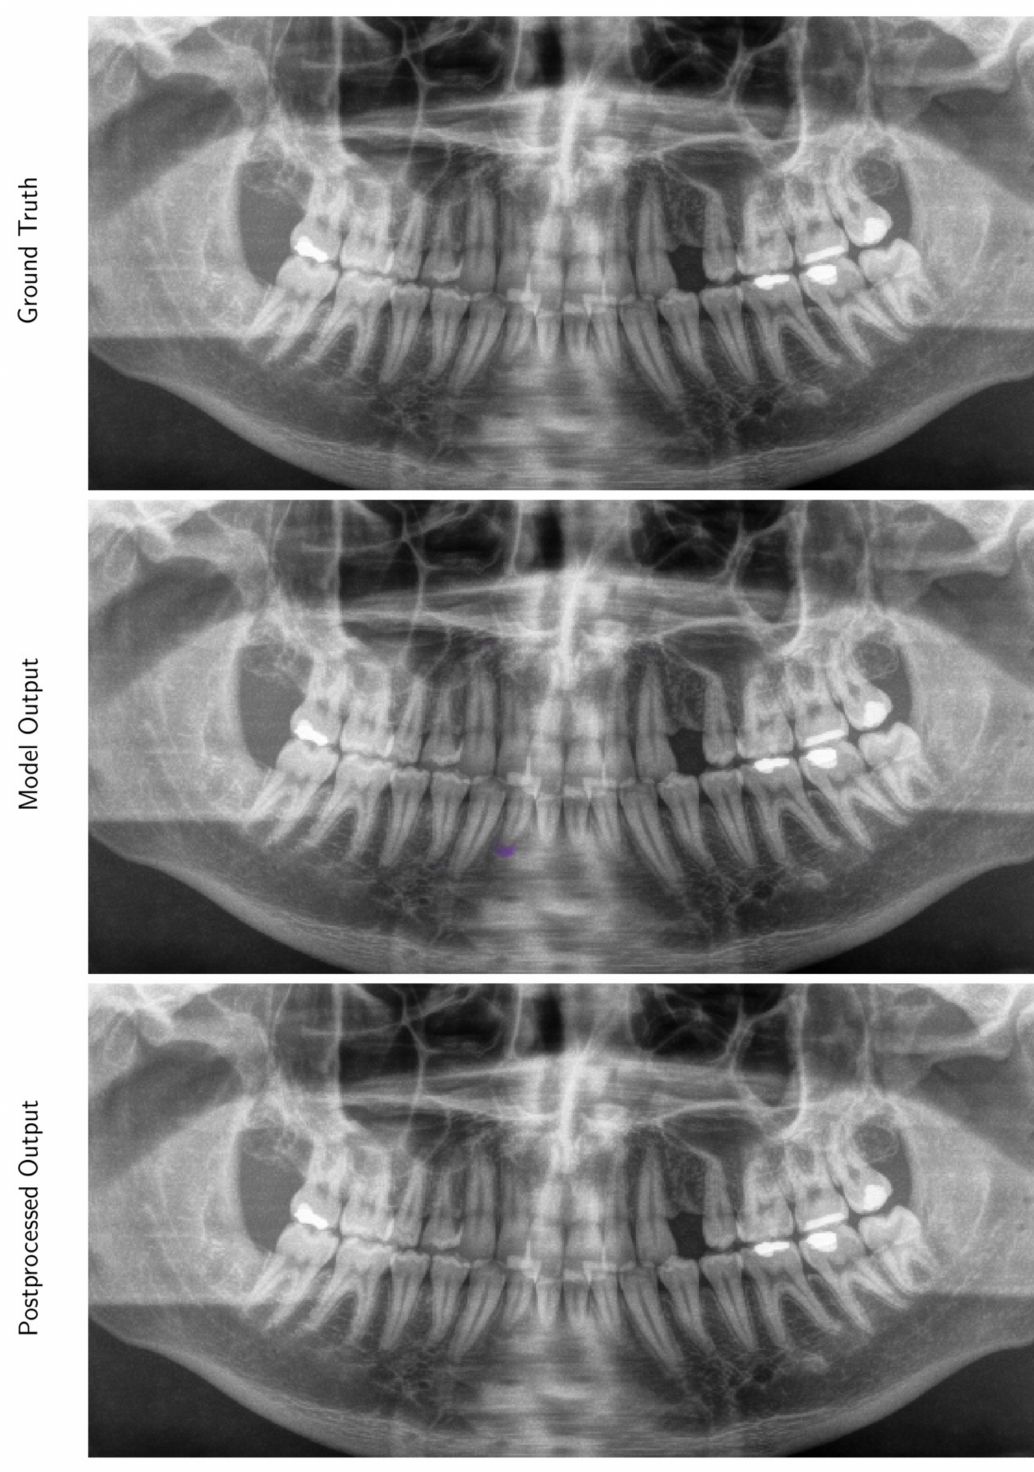
Figure A4. Example 4; see Figure A1 for